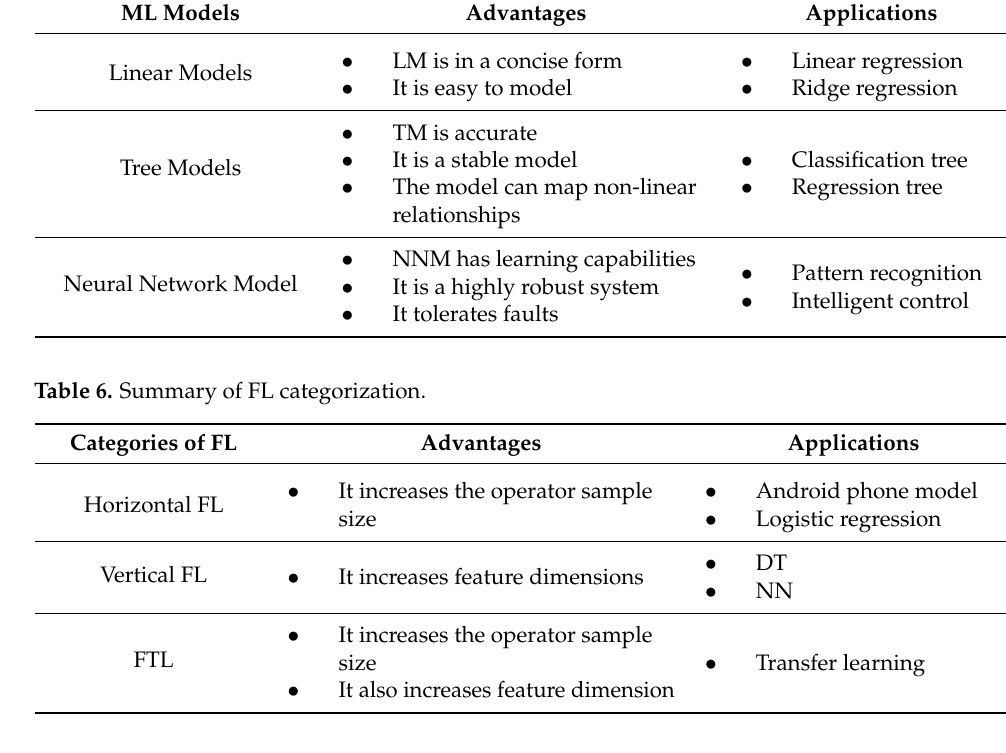
Table 7. Summary of FL application in mobile